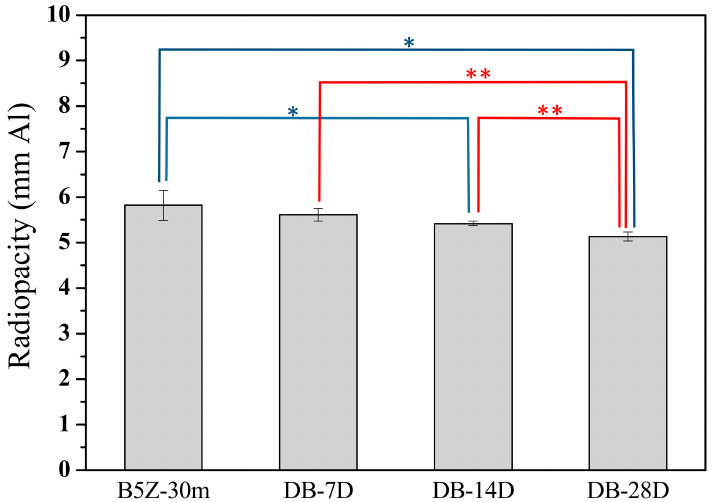
Figure 7. Radiopacity of MTA-like cements stored in an electronic dry box for 7, 14, and 28 days (i.e., DB-7D, 14D, and 28D, respectively). * and ** indicated that these two sets of samples were statistically di ff erent at a 95% and 99% confidence interval,